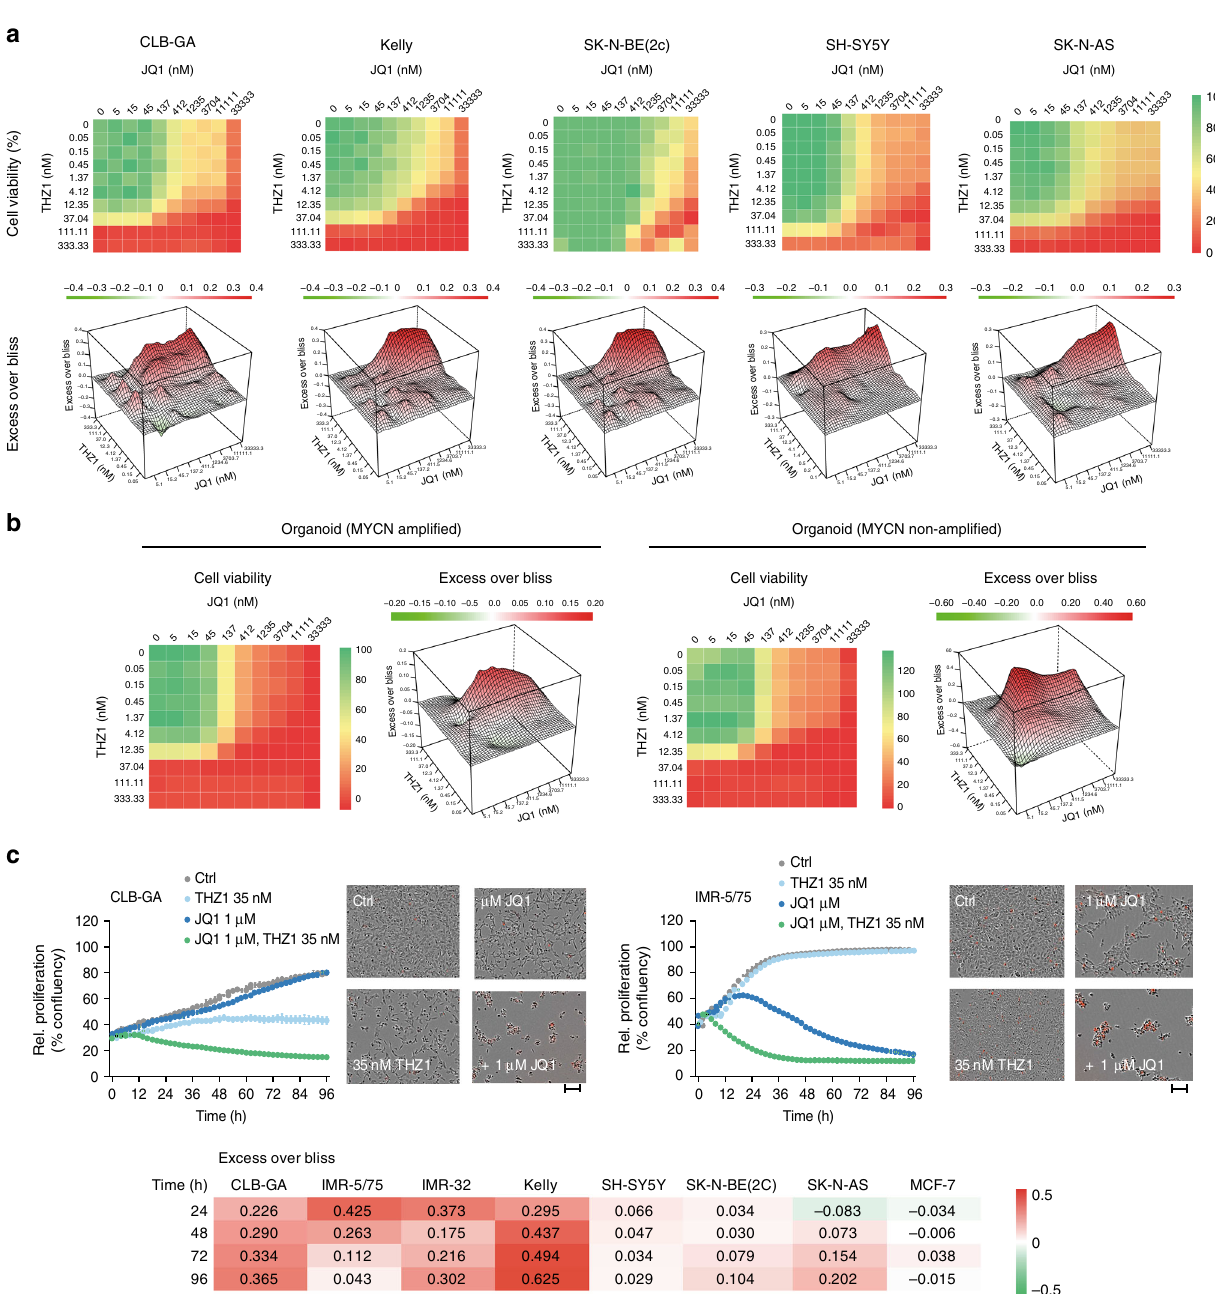
Fig. 7 Combined CDK7-BET inhibition as a novel therapeutic approach. a Heatmap with the percentage of cell viability for serial dilutions of JQ1 (5.1 nM – 33.3 μ M) in combination with THZ1 (0.051 nM – 0.333 μ M) in Kelly, SK-N-BE(2c), SK-N-AS, IMR-32, CLB-GA, and SHS-Y5Y), 72 h upon treatment; and respective 3D representation of Excess over Bliss scores. Excess over Bliss scores >0 indicates drug synergy, <0 indicates drug antagonism. Data points in the screen represent mean of two technical replicates. b Heatmap with the percentage of cell viability for serial dilutions of JQ1 (5.1 nM – 33.3 μ M) in combination with THZ1 (0.051 nM – 0.333 μ M) in two organoids (one MYCN ampli fi ed and one MYCN non-ampli fi ed, 5 days upon treatment); and respective 3D representation of Excess over Bliss scores. Excess over Bliss scores >0 indicates drug synergy, <0 indicates drug antagonism. Data points in the screen represent mean of two technical replicates. c Synergistic effect on proliferation (% con fl uency) over time for the cell lines CLB-GA and IMR-5/75 upon treatment with 35 nM THZ1 and 1 µ M JQ1. One biological replicate out of three is shown, error bars represent the s.d. of the three technical replicates. Microscopic pictures of the cells 60 h upon treatment are depicted at the right (scale bar is 100 µ m). Red staining of the cells indicates apoptosis (AnnexinV positivity). Bliss score was used to calculate potential synergism for 7 NB cell lines and the negative control MCF-7 breast cancer cell line. Excess over Bliss scores >0 indicates drug synergy, <0 indicates drug